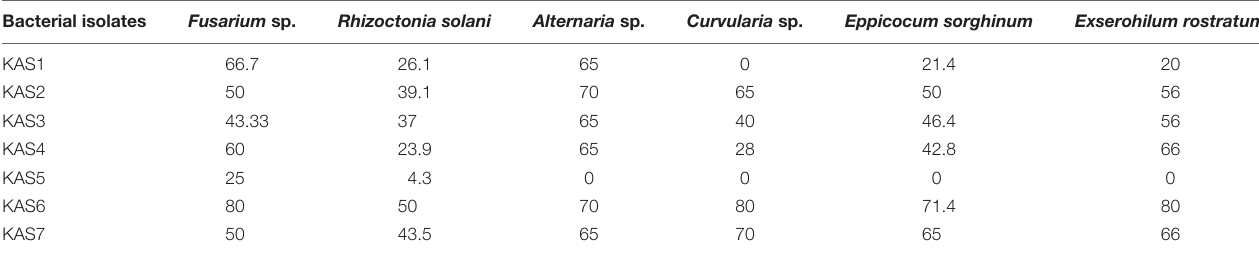
FIGURE 4 | Microscopic visualization of bacteria on or in roots of pearl millet seedlings after SYTO-9 staining under fluorescence microscope. Where, in (a,b) several bacteria were observed on the root surfaces and inside of the root parenchyma and hair cells of positive control seedlings (arrows); (c,d) no bacteria were observed onto root surfaces and root hairs of negative control seedlings; (e–g) KAS1 ( Kosakonia cowanii ), KAS4 ( Pantoea stewartii ), and KAS6 ( Pseudomonas aeruginosa ) were observed on surfaces of root and in intercellular spaces of root parenchyma cells, respectively (arrows). TABLE 3 | Antagonistic activity (as% inhibition) of endophytic bacteria against selected fungal phytopathogens in dual plate culture. Bacterial isolates Fusarium sp. Rhizoctonia solani Alternaria sp. Curvularia sp. Eppicocum sorghinum Exserohilum